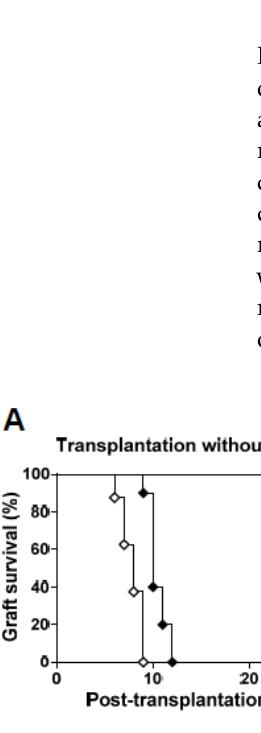
Figure 2. Survival of the facial flaps in the osteomyocutaneous (OMC) and myocutaneous (MC) allograft groups. ( A ) The survival rate of facial allografts in the OMC and MC graft groups without an immunosuppressive regimen. Fully major histocompatibility complex-incompatible BALB/c allografts were grafted onto the necks of C57BL/6 mice. The syngeneic group had facial grafts from C57BL/6 mice. The syngeneic OMC, syngeneic MC, allogeneic OMC, and allogeneic MC groups included a total of nine, six, ten, and eight mice, respectively. The Kaplan–Meier method was utilized to calculate the survival rate. The differences between the allogeneic OMC and MC groups were significant ( p < 0.005). ( B ) Survival rate of facial flaps in the OMC and MC allograft groups with an immunosuppressive regimen. Two dosages of FK506 (0.6 and 2 mg/kg) were administered to transplanted mice via intraperitoneal injection for 21 days. The allogeneic OMC and MC groups receiving 0.6 mg/kg of FK506 had a total of five mice each. FK shown in ( B ) is the FK506 abbreviation. The allogeneic OMC and MC groups receiving 2 mg/kg of FK506 also had a total of five mice each. The differences between allogeneic OMC and MC groups for both dosages were significant ( p < 0.005).